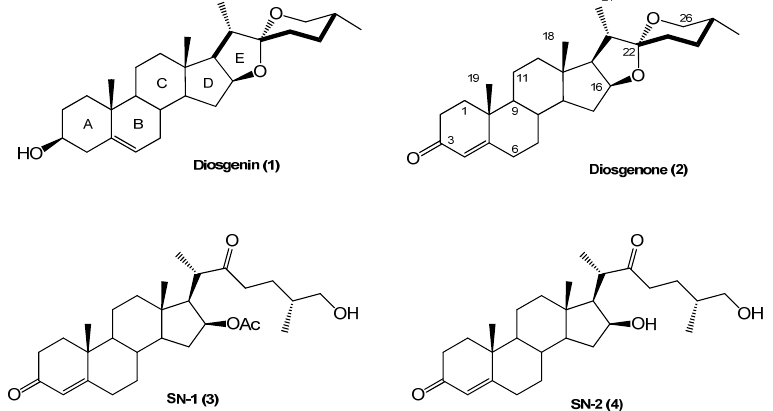
Figure 1. Structure of diosgenin and diosgenone, SN-1 and SN-2 S. nudum